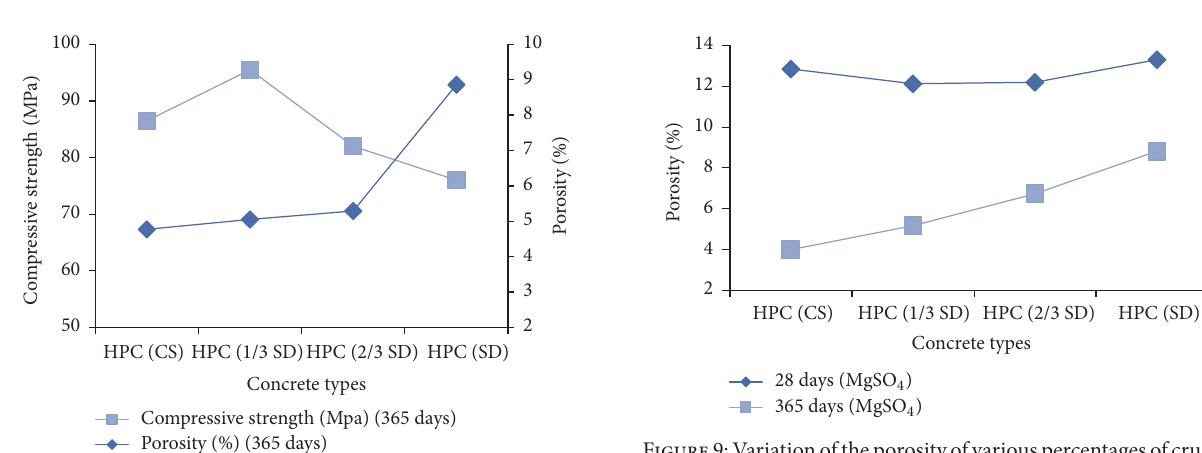
Figure9:Variationoftheporosityofvariouspercentagesofcrushed sand conservation in solution MgSO 4 .